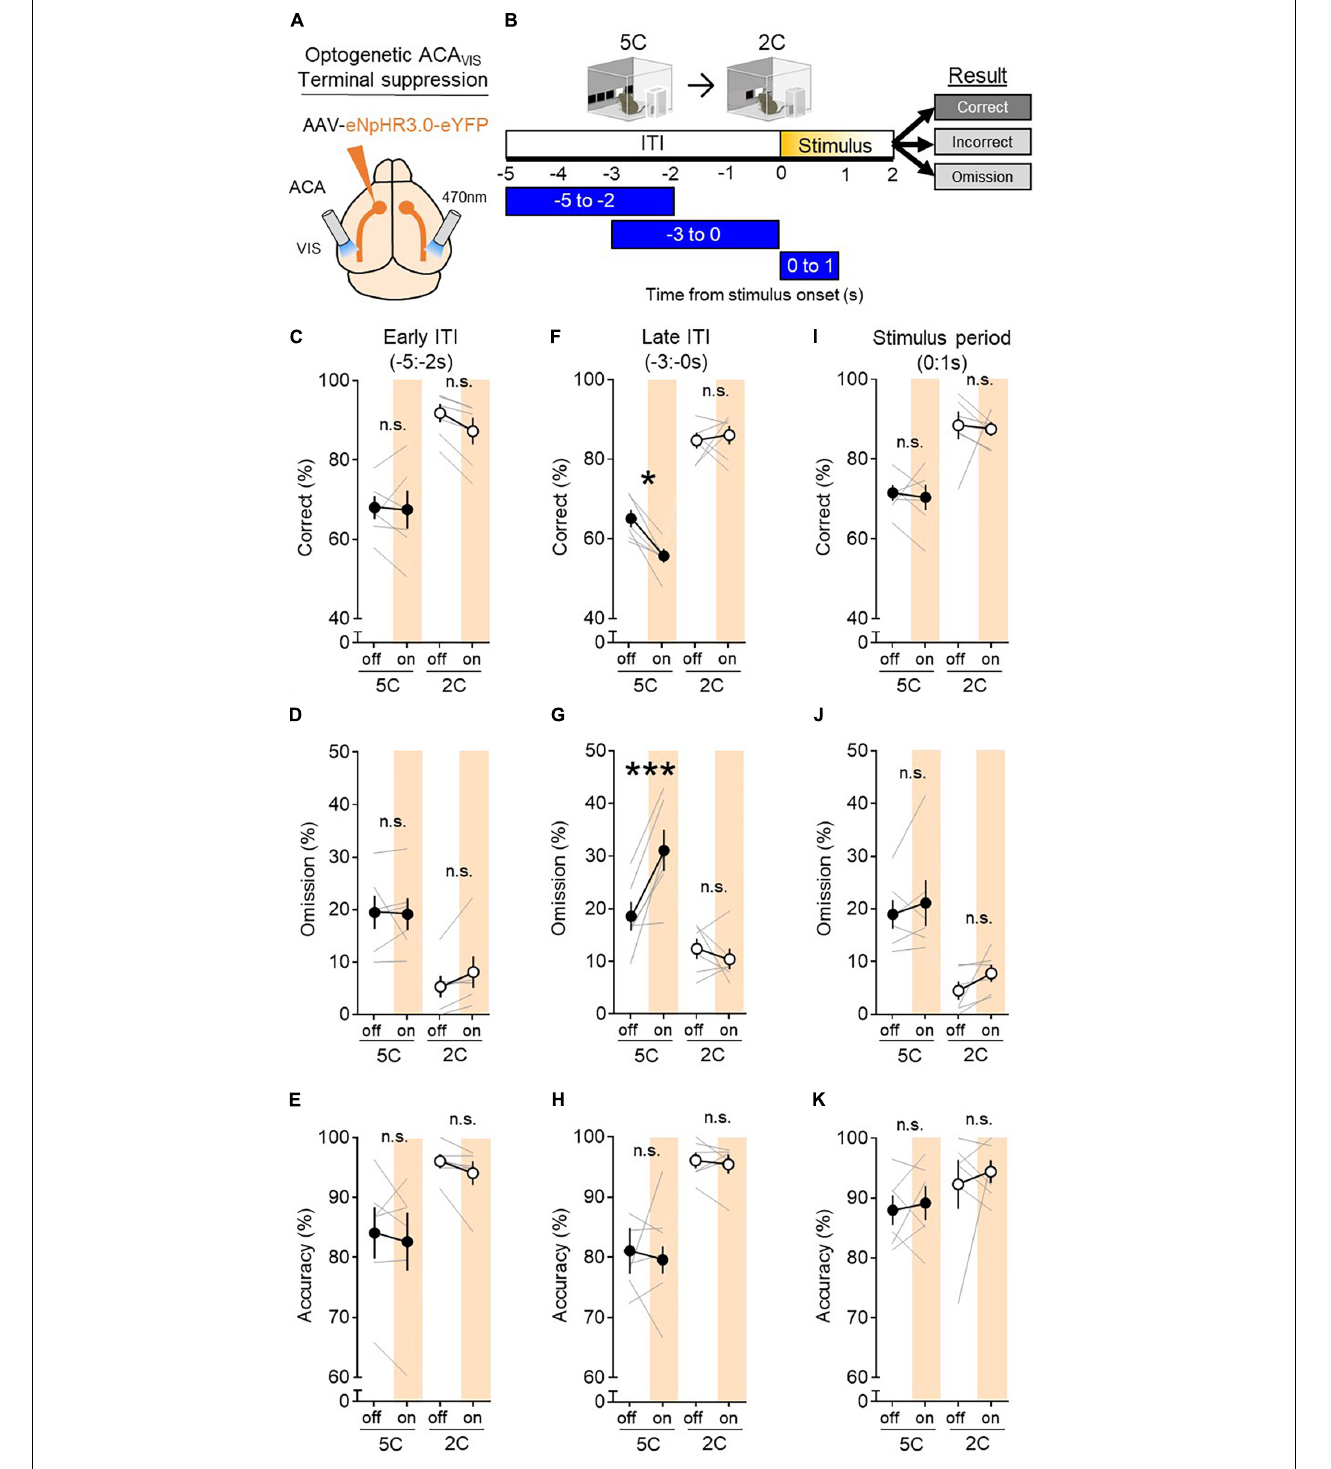
FIGURE 3 | ACA VIS projections, while required for 5CSRTT, are dispensable for 2CSRTT. (A) Viral strategy: To express light-gated chloride channel eNpHR3.0 in excitatory ACA neurons, eNpHR3.0 encoding AAV under the CaMKII promoter was injected in the ACA. An optic fiber was implanted at the VIS to optically suppress ACA VIS projection terminals with temporal precision during the 5CSRTT. (B) Experimental timeline: Mice were first trained on the 5CSRTT, before viral injection. After allowing 3 weeks for maximal viral expression, mice underwent 5CSRTT testing. During 5CSRTT testing, with a fixed 5 s ITI and pseudorandomized